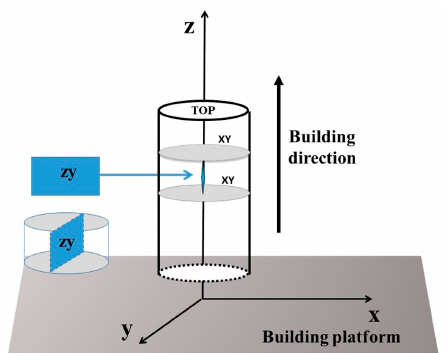
Figure 1. Schematic representation of the as-built HX cylinders built along the building direction; the x-y plane is perpendicular to the building direction, while the z-y plane is parallel to the building direction.